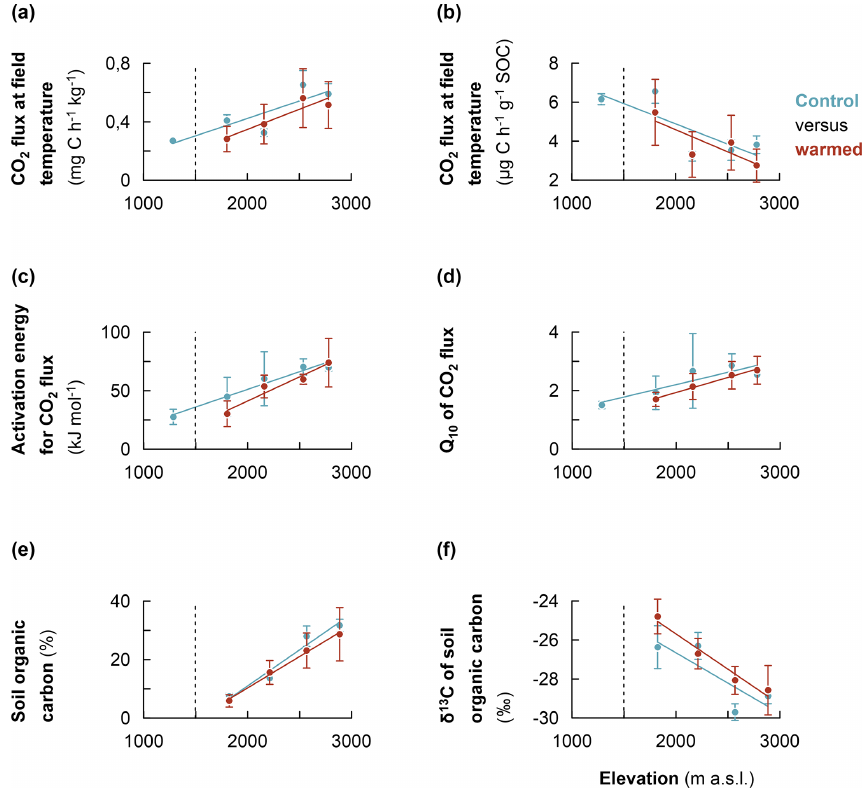
Figure 4. Comparison of the warming response of soil organic carbon along the Rwenzori elevation gradient. (a) Heterotrophic CO 2 respi- ration rates of control and warmed soils (measured at the translocated in situ temperature). (b) The same as for the specific CO 2 respiration rates. (c) Activation energy for control and warmed soil. (d) Sensitivity of CO 2 respiration rates to temperature ( Q 10 ) for control and warmed soil. (e) Soil organic carbon content for control and warmed soil. (f) δ 13 C values of soil organic carbon for control and warmed soil. Mean values were calculated from composite soil samples per elevation cluster ( n = 4). The error bars indicate the standard deviation from the mean. For the measurement of δ 13 C values, the standard used was the international VPDB (Vienna Pee Dee